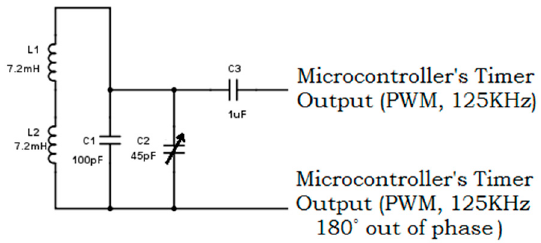
Figure 5. Radio Frequency (RF) transmitter circuit of the hand module.